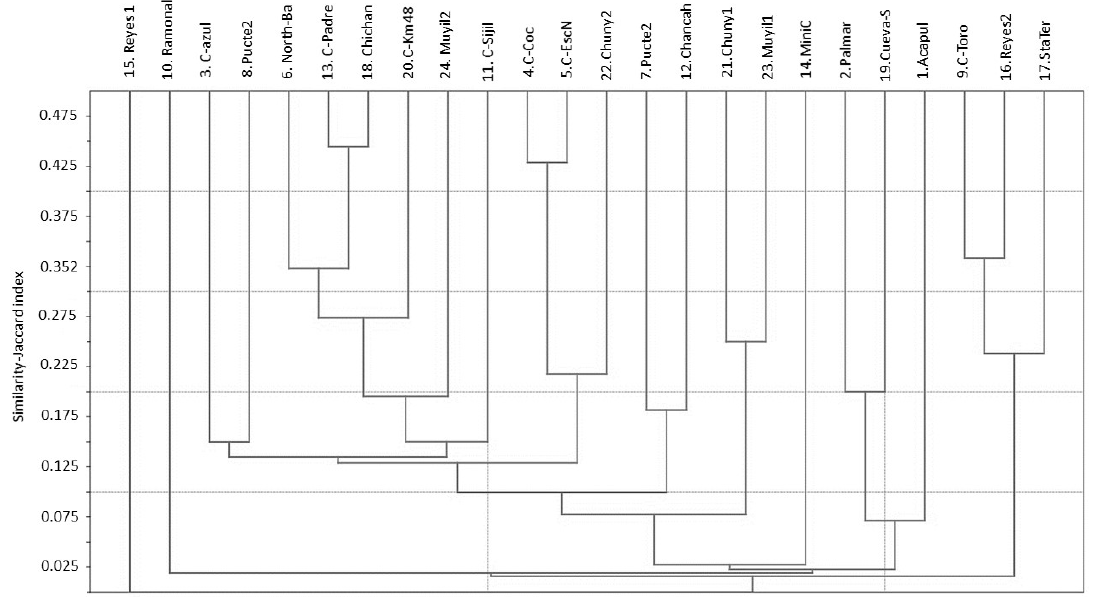
Figure 9. Similarity in water mites’ composition between locations. Numbers in front of location name are the same as in Table 1.